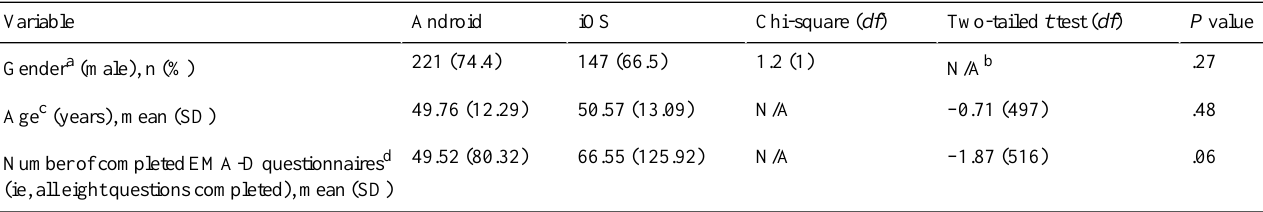
Table 3. Comparisons between iOS and Android users regarding gender, age, and number of completed dynamic ecological momentary assessment (EMA-D) questionnaires.